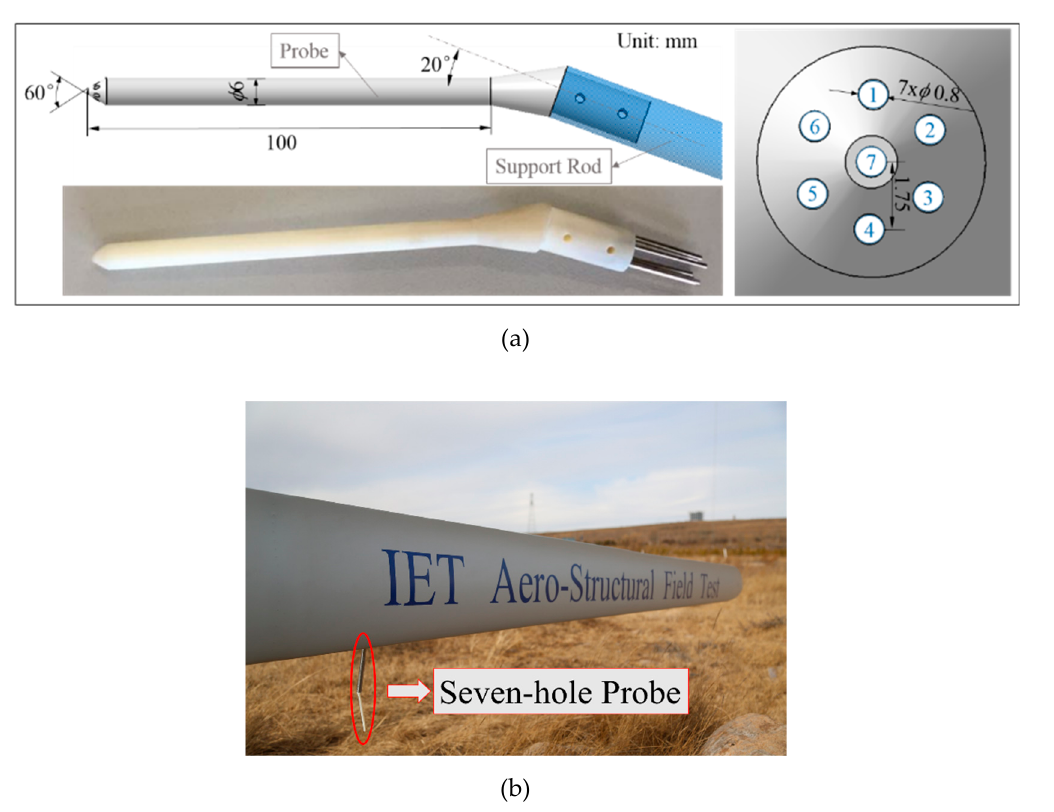
Figure 4. ( a ) Geometry of seven-hole probe, and ( b ) photo of the probe at the leading edge.